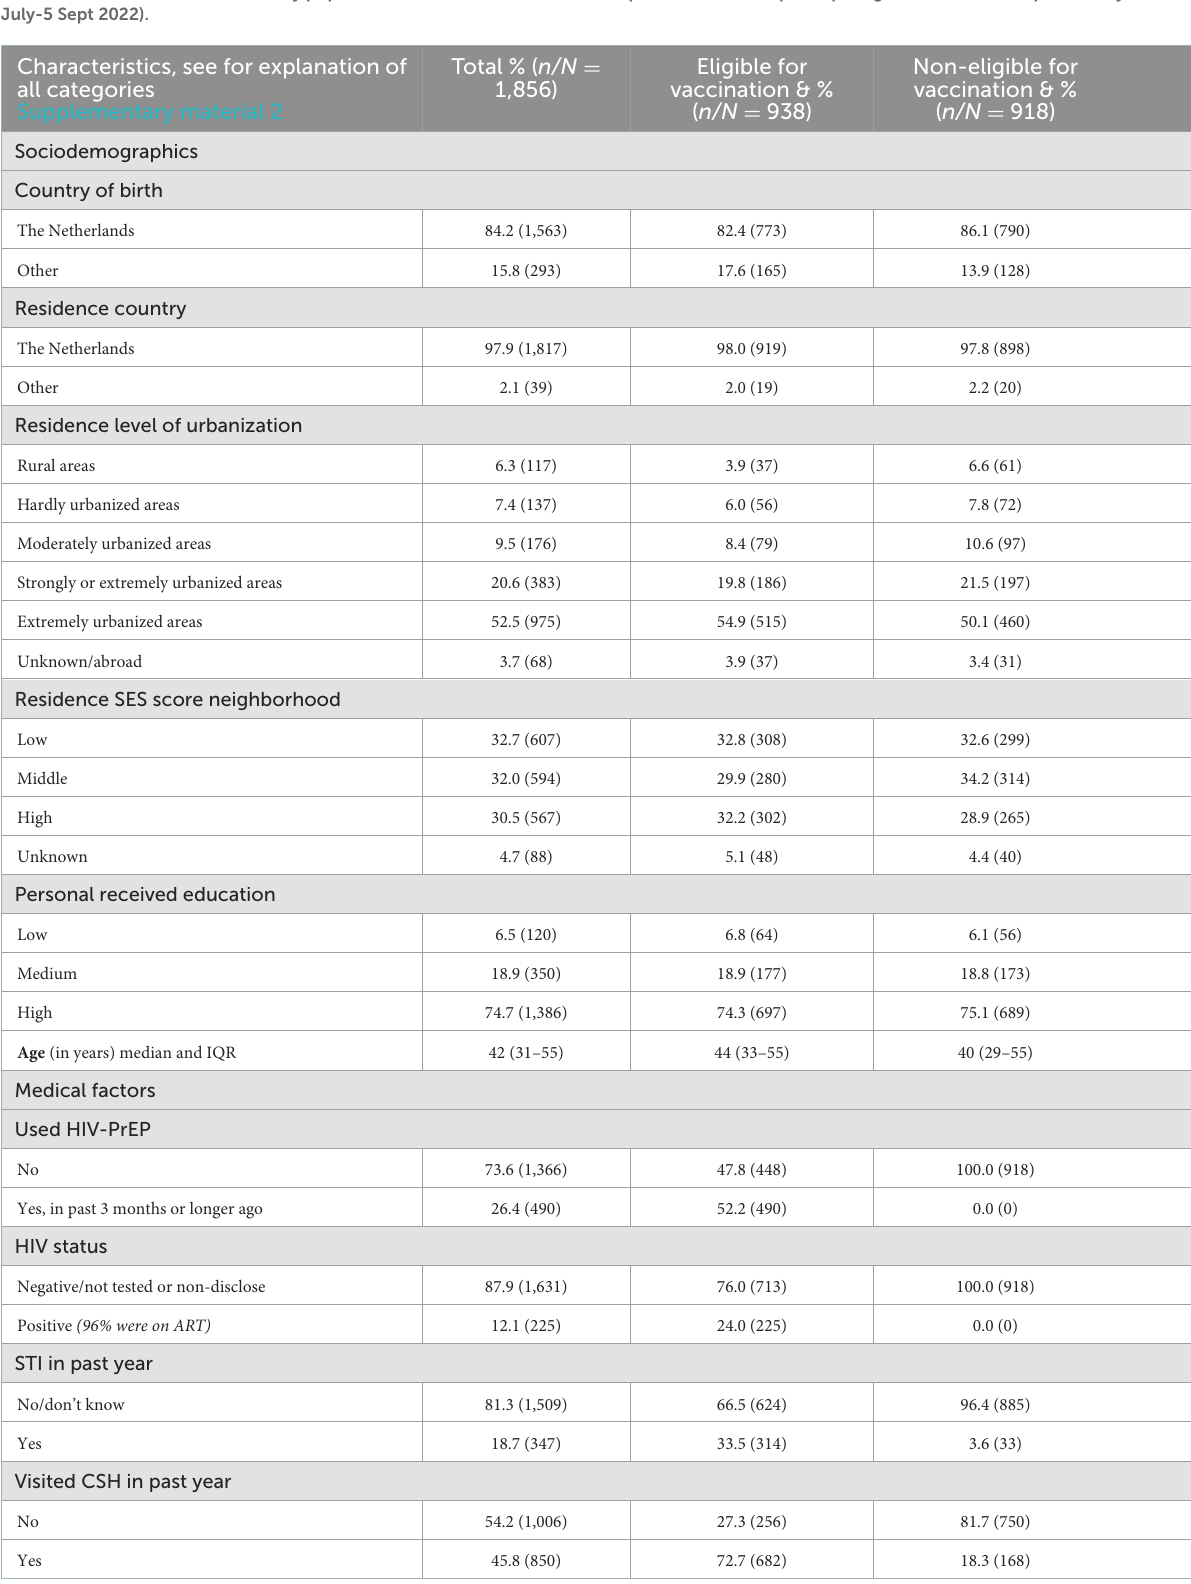
TABLE 1 Characteristics of the study population who are unvaccinated for mpox; GBMSM/TGP participating in Dutch online mpox-survey (22 July-5 Sept 2022). Characteristics, see for explanation of all